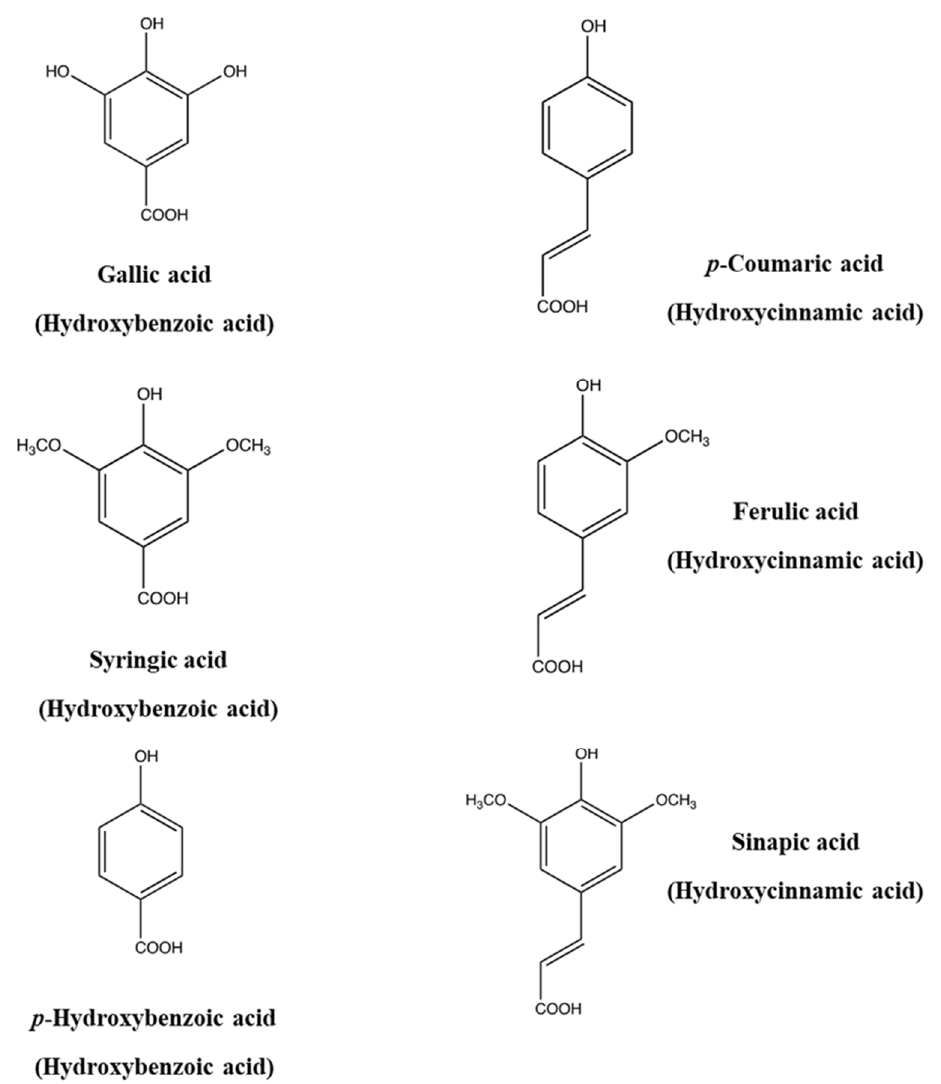
Figure 1. Chemical structures of representative phenolic acids.